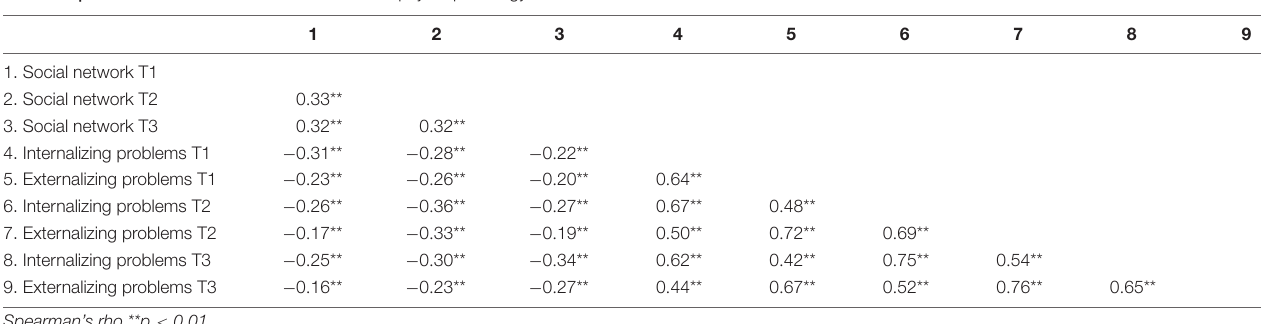
TABLE 2 | Correlations between social network and psychopathology.